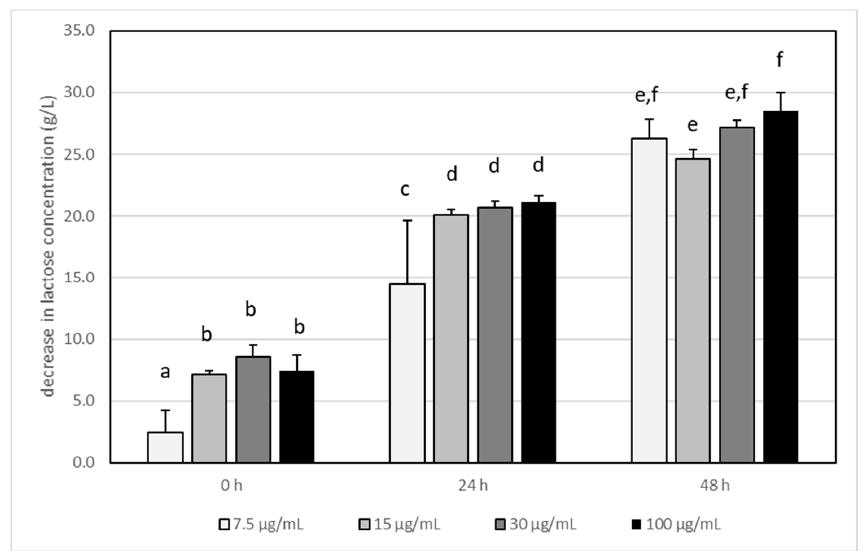
Figure 1. The influence of acrylamide (AA) concentration on lactose degradation by Lactobacillus acidophilus LA-5 in milk during incubation at 37 °C. Bars represent the differences (arithmetic mean ± SD, n = 6) in lactose concentration between control (i.e., milk without AA) and test sample (milk with adequate AA concentration) The means with different letters (a–f) differ from each other at the level of p < 0.05 (ANOVA with Tukey–Kramer post hoc test).